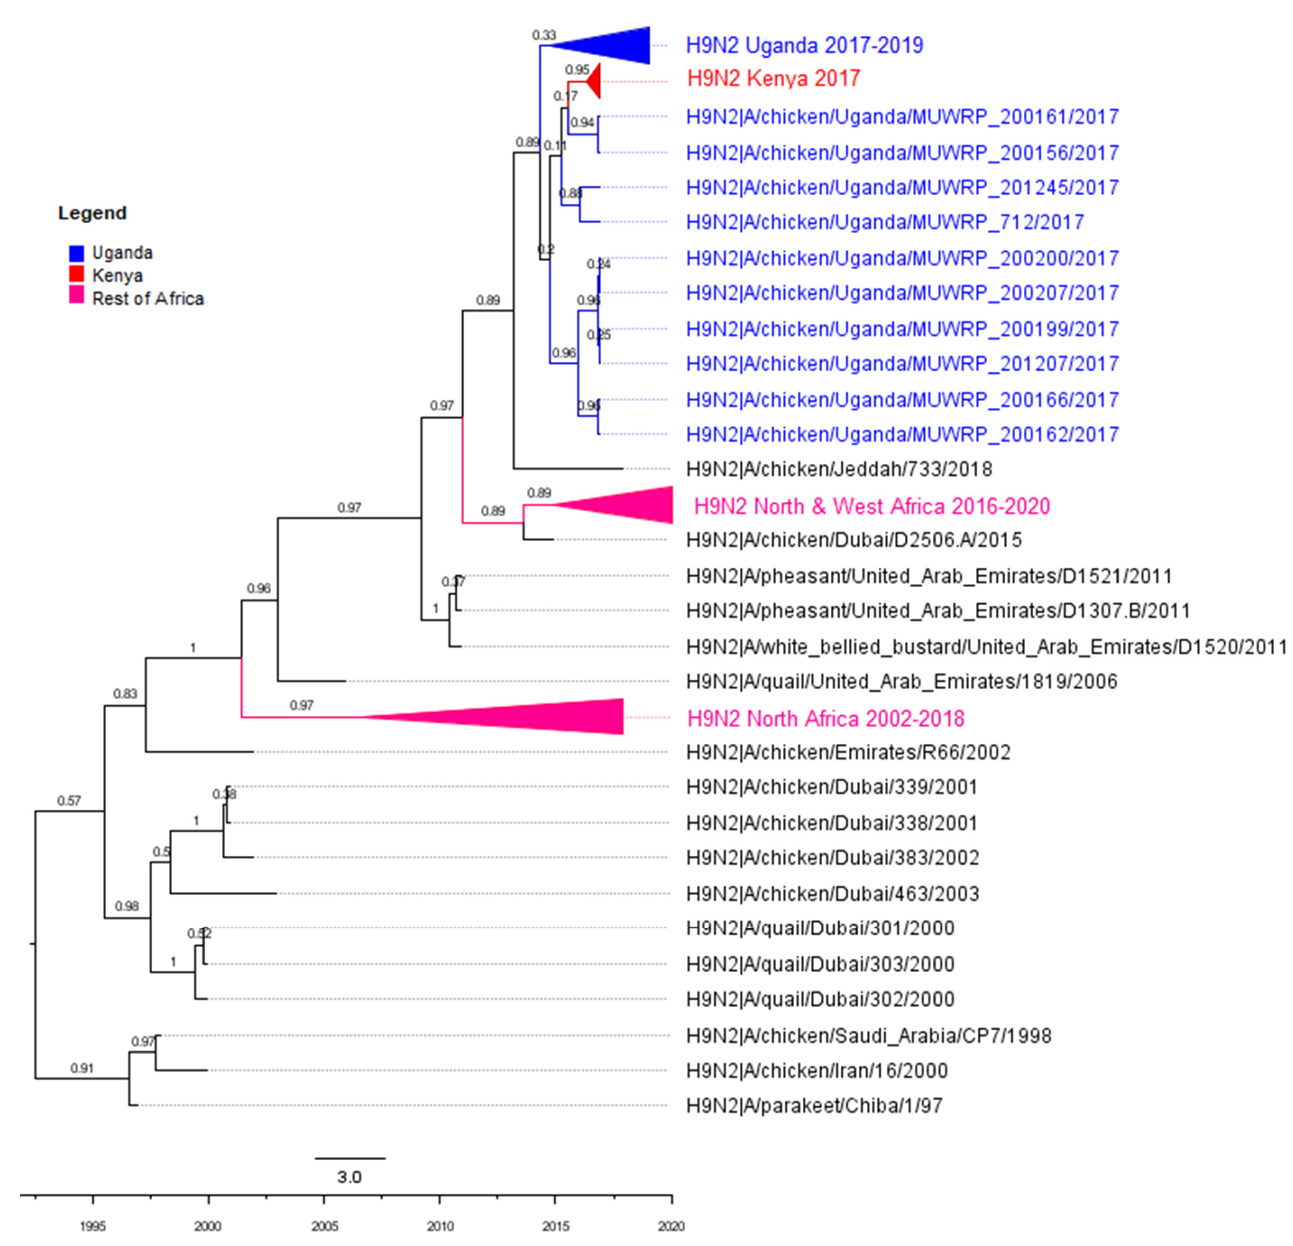
Figure A5. Phylogenetic tree for NA. Ugandan viruses are highlighted in blue, Kenyan in red, North and West African countries in pink. tMRCA for Uganda is May 2014. Posterior probabilities are shown on the branches. Scales represent substitutions and time.